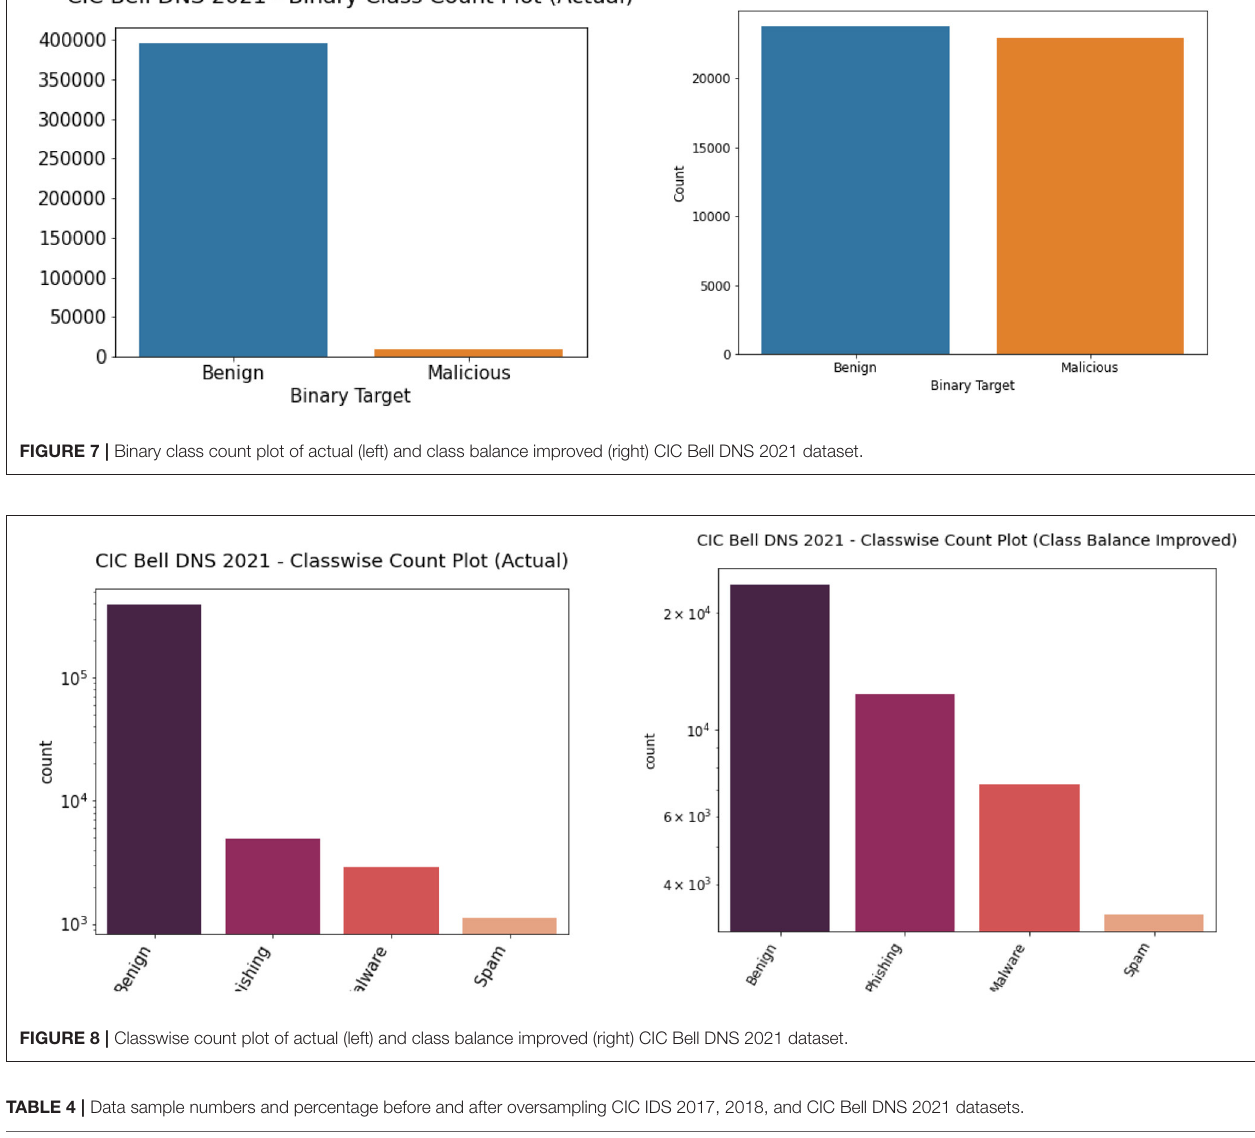
TABLE 4 | Data sample numbers and percentage before and after oversampling CIC IDS 2017, 2018, and CIC Bell DNS 2021 datasets. Actual Balanced Actual Percentage Balanced Percentage Benign Malicious Benign Malicious Benign Malicious Benign